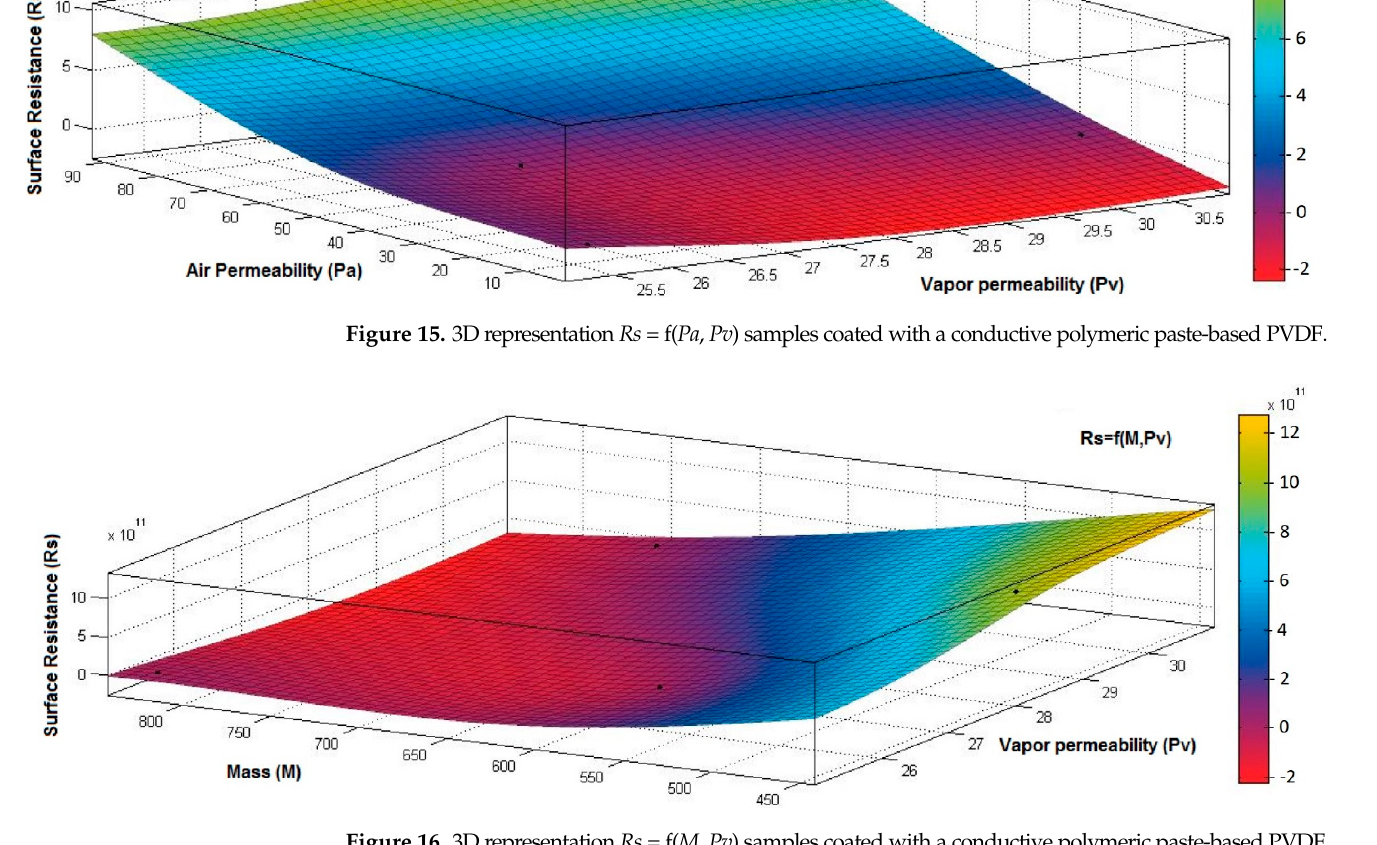
Figure 16. 3D representation Rs = f( M , Pv ) samples coated with a conductive polymeric paste-based PVDF.